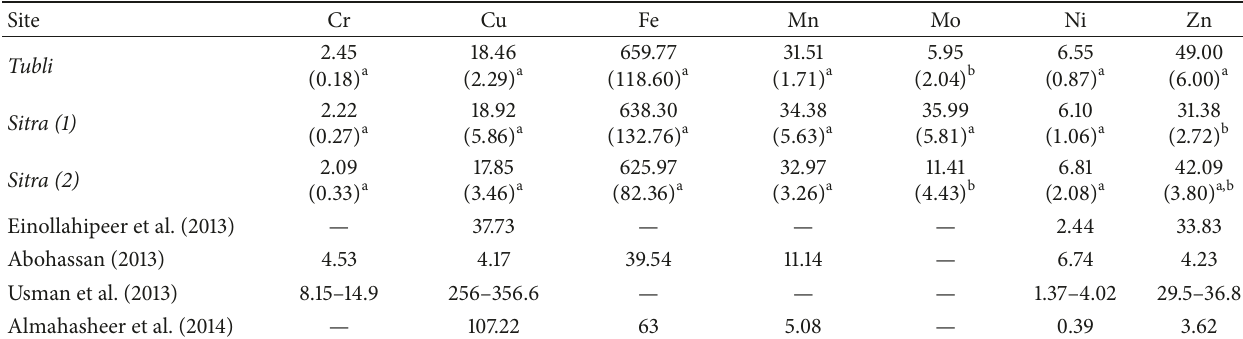
Table 1: Mean concentrations of heavy metals in mgL −1 ( ± SEM) ( 𝑛 = 6 ) in the leaves of gray mangrove ∗ .